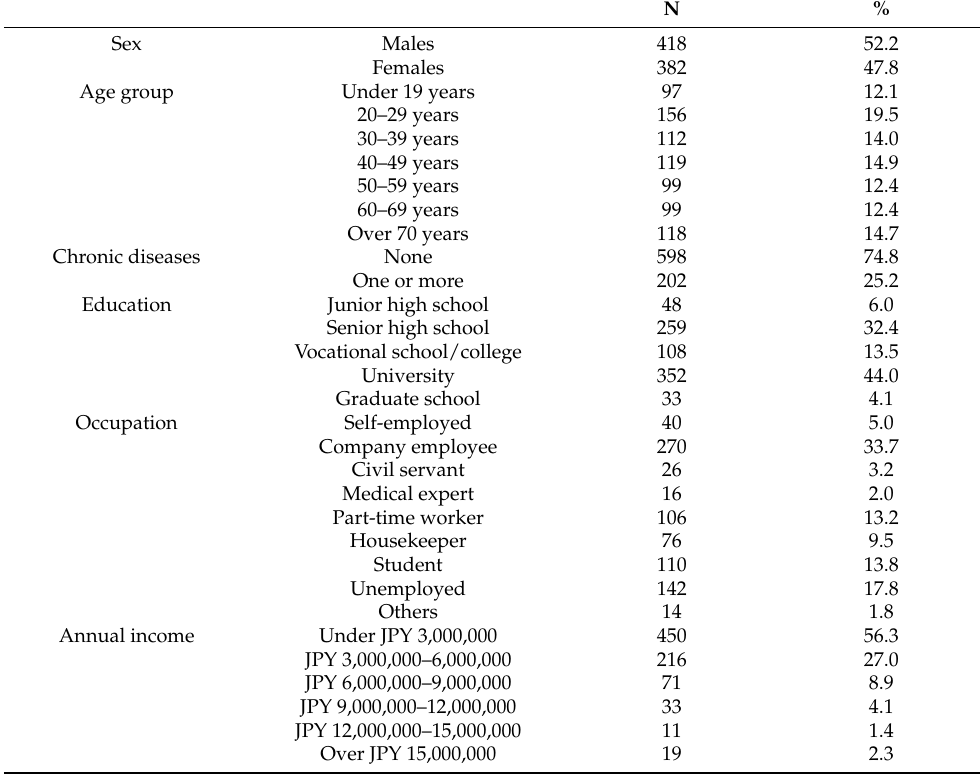
Table 1. Characteristics of